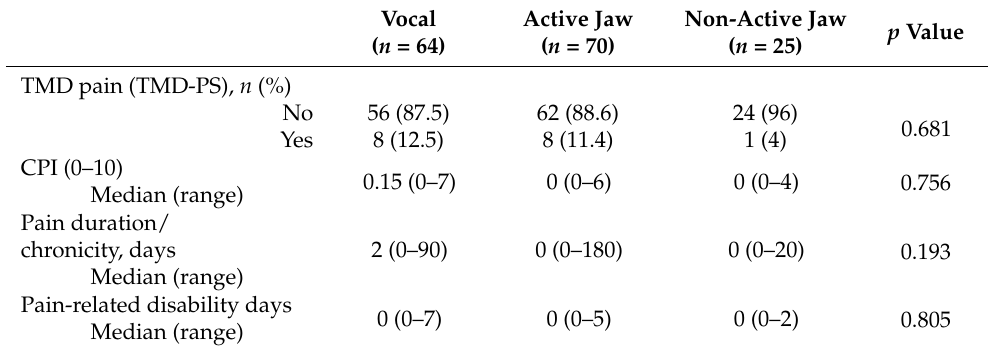
Table 3. Comparison of pain outcomes such as TMD pain prevalence, characteristic pain intensity (CPI), pain chronicity, pain-related disability among